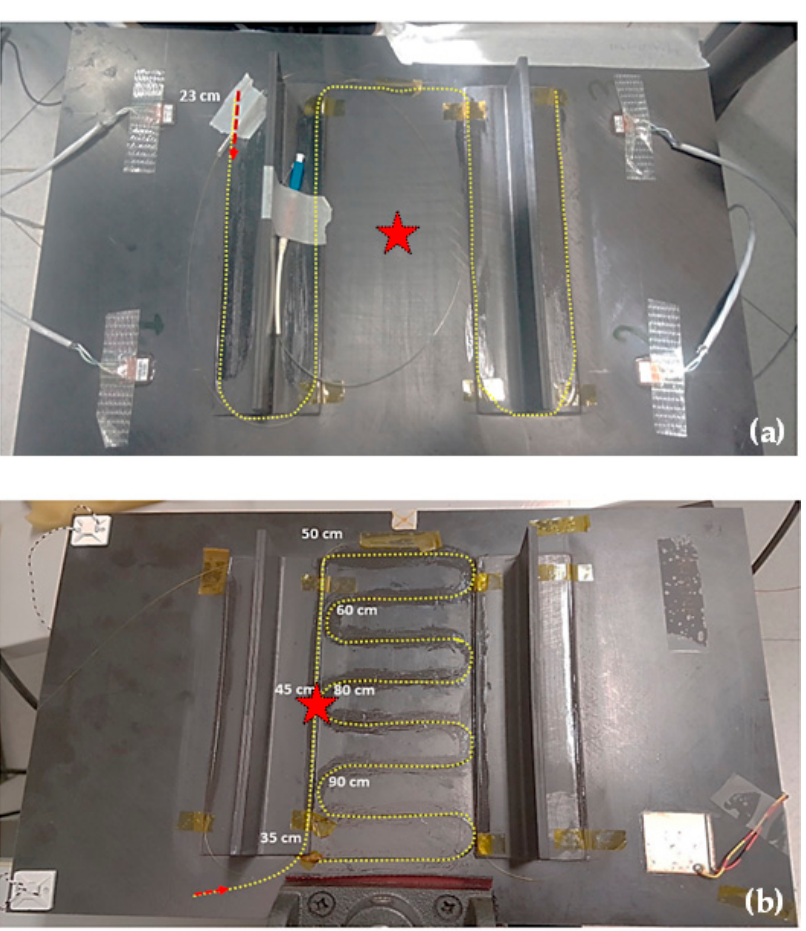
Figure 7. Sensor layout dotted line: on PNL1 all along the stringer perimeter ( a ); on PNL2 along the inner line of left stringer and on the skin ( b ). The red arrow indicates the light insertion origin.